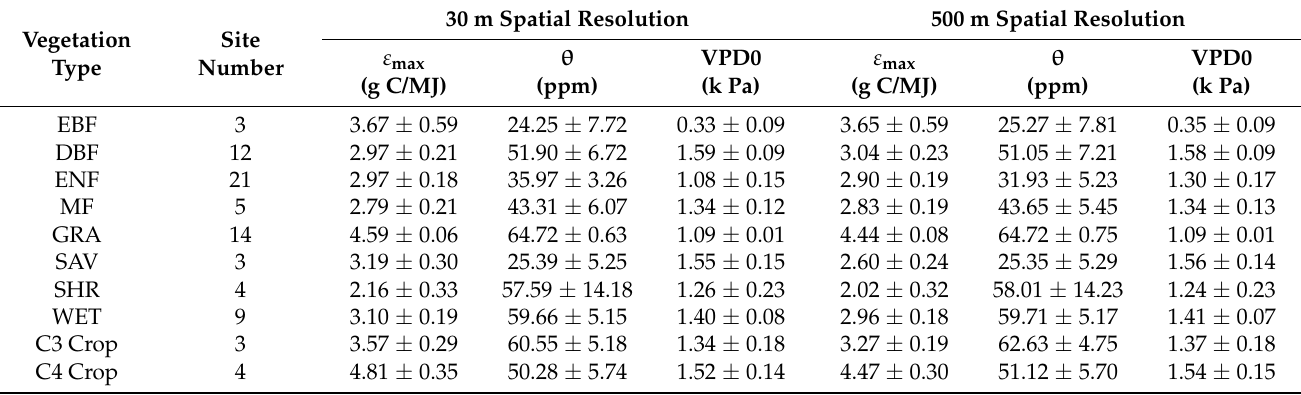
Table 1. The mean value and standard deviations of estimated parameters for revised EC-LUE model at 30 m spatial resolution (Landsat) and 500 m spatial resolution